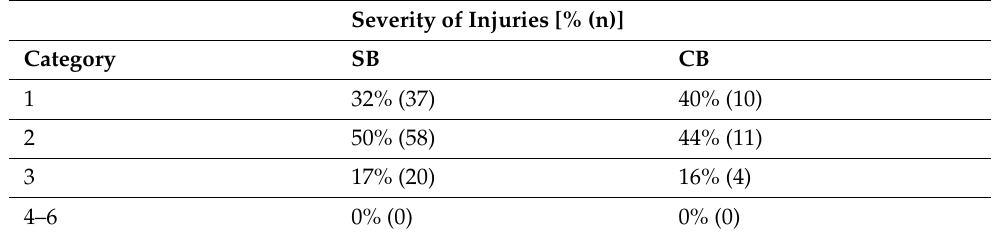
Table 6. Distribution of injuries in the social box (SB) and the conventional box (CB) stabling by severity assessed in three categories (1 = scratched and/or missing hair, 2 = hair loss, skin irritation, 3 = skin lesions, traces of blood and/or thin